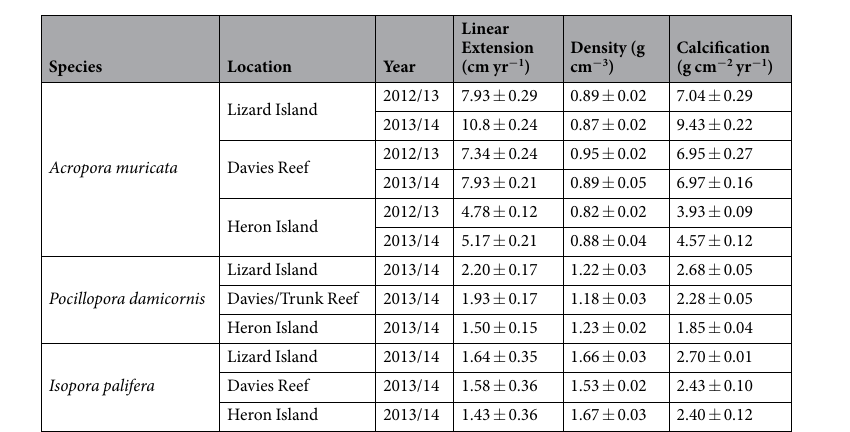
Table 1. Summary of the annual growth parameters, linear extension (cm yr − 1 ), density (g cm − 3 ), and calcification (g cm − 2 yr − 1 ) (Mean ± SE), for A . muricata , P . damicornis and I . palifera at Lizard Island, Davies/ Trunk Reefs and Heron Island from 2012/13 and